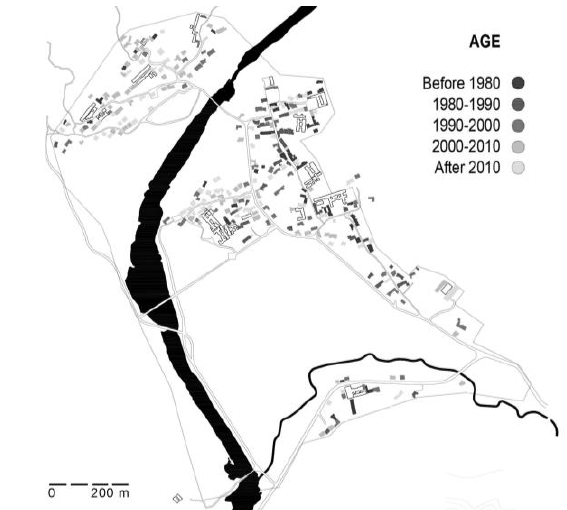
Figure 4. Buildings' period. Elaboration by the first